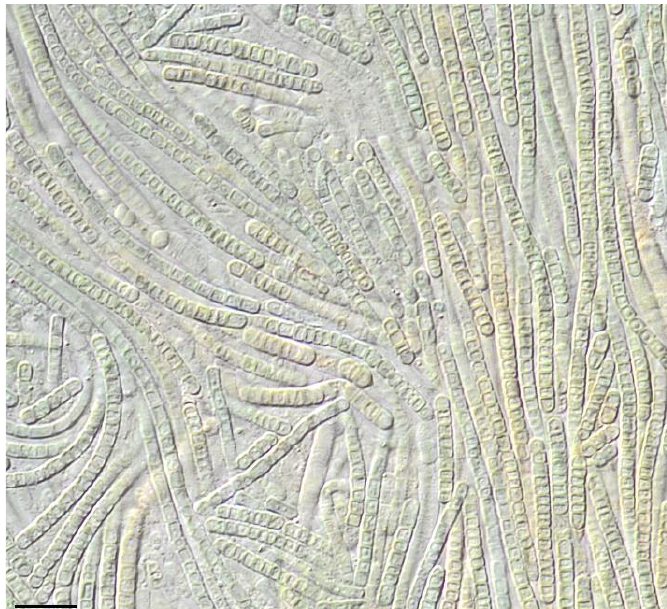
Figure 7. DIC micro-photographs of Apatinema mutabilis. Scale 10 μm.